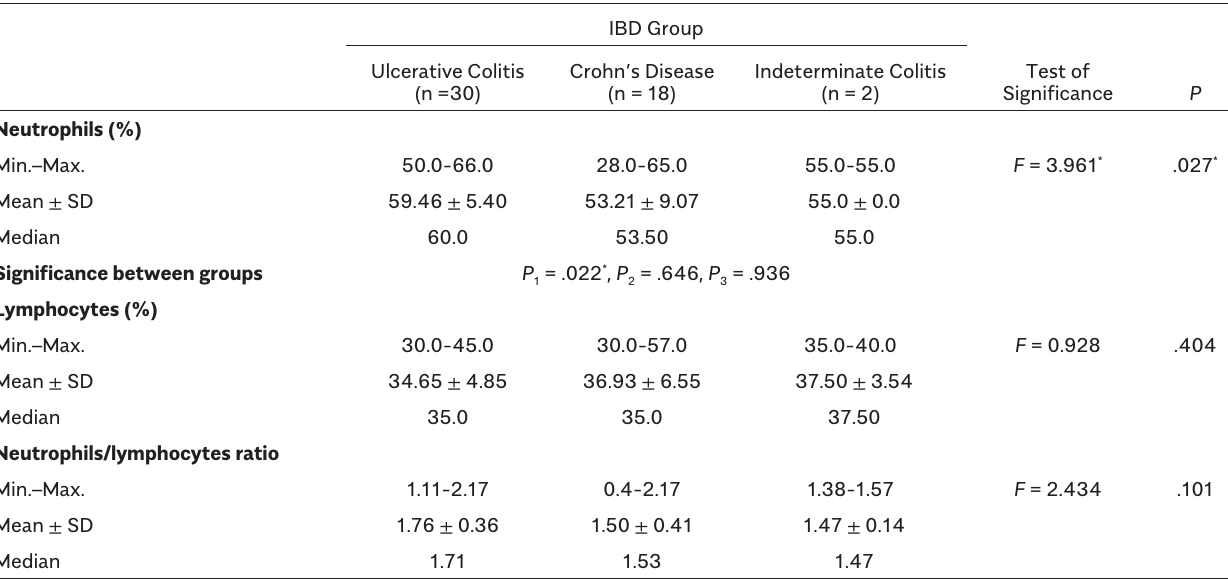
Table 1. Comparison Between the 3 Studied Groups According to Different Parameters